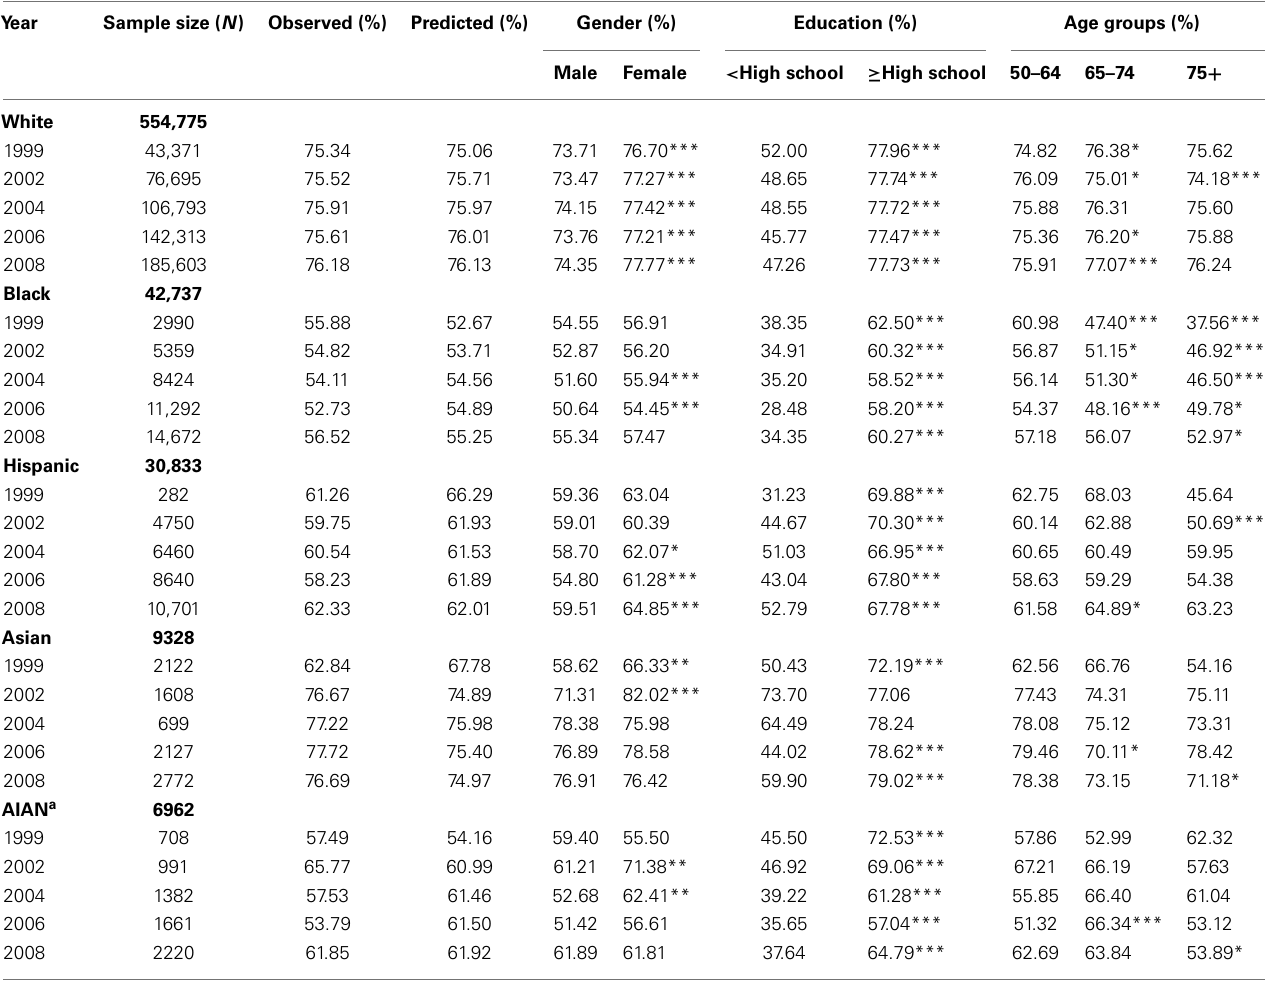
Table 2 |Trend of last dental cleaning by racial/ethnic groups (1999–2008)